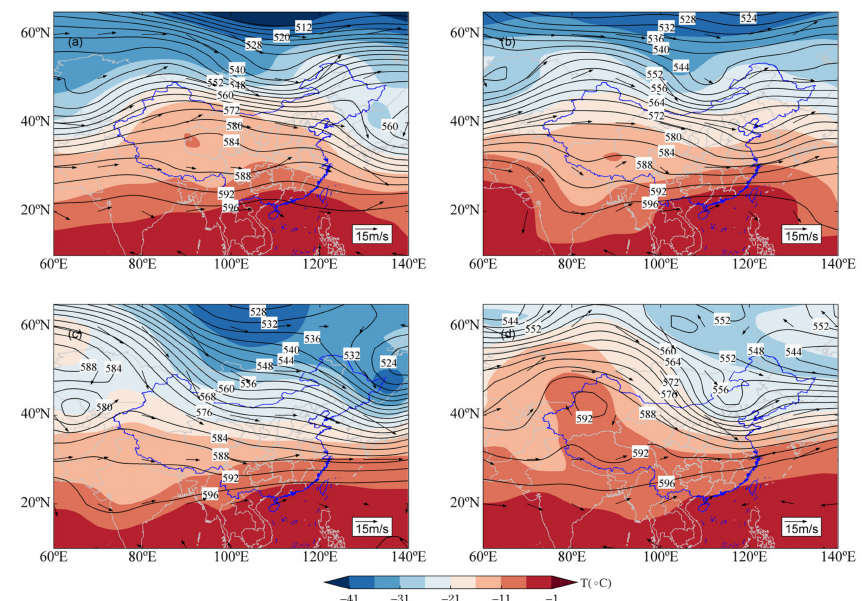
Figure 9. Distribution of the 500 hPa height field, wind field, and temperature field during four SDS events (( a ) 13–18 March, ( b ) 27 March–1 April, ( c ) 14–16 April, and ( d ) 6 May–8 May) in spring 2021.